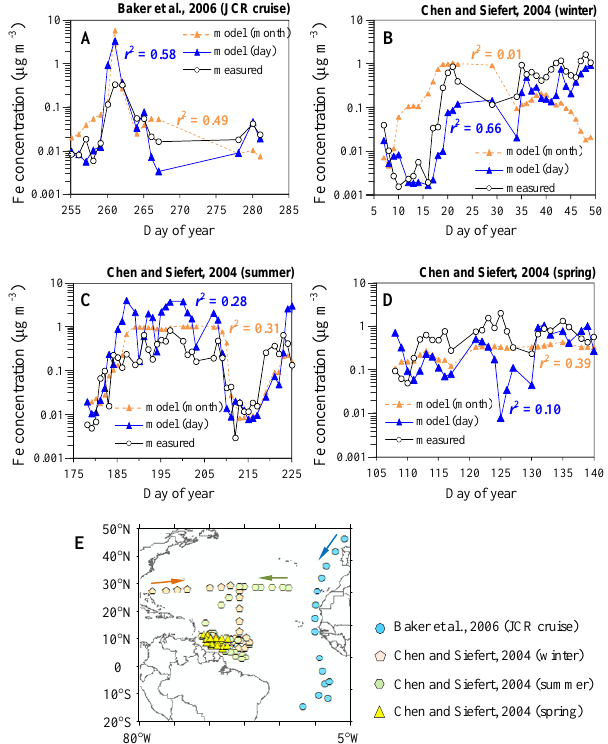
Figure 8. Comparisons of modelled and measured Fe concentra- tions. The Fe concentrations were derived as monthly (blue tri- angles) or daily (orange triangles) means from the model. (a) Fe measured in autumn 2001 (James Clark Ross (JCR) cruise) by Baker et al. (2006). (b) Fe measured in winter 2001 by Chen and Siefert (2004). (c) Fe measured in summer 2001 by Chen and Siefert (2004). (d) Fe measured in spring 2003 by Chen and Siefert (2004). (e) Locations of the cruise measurements (a–d)